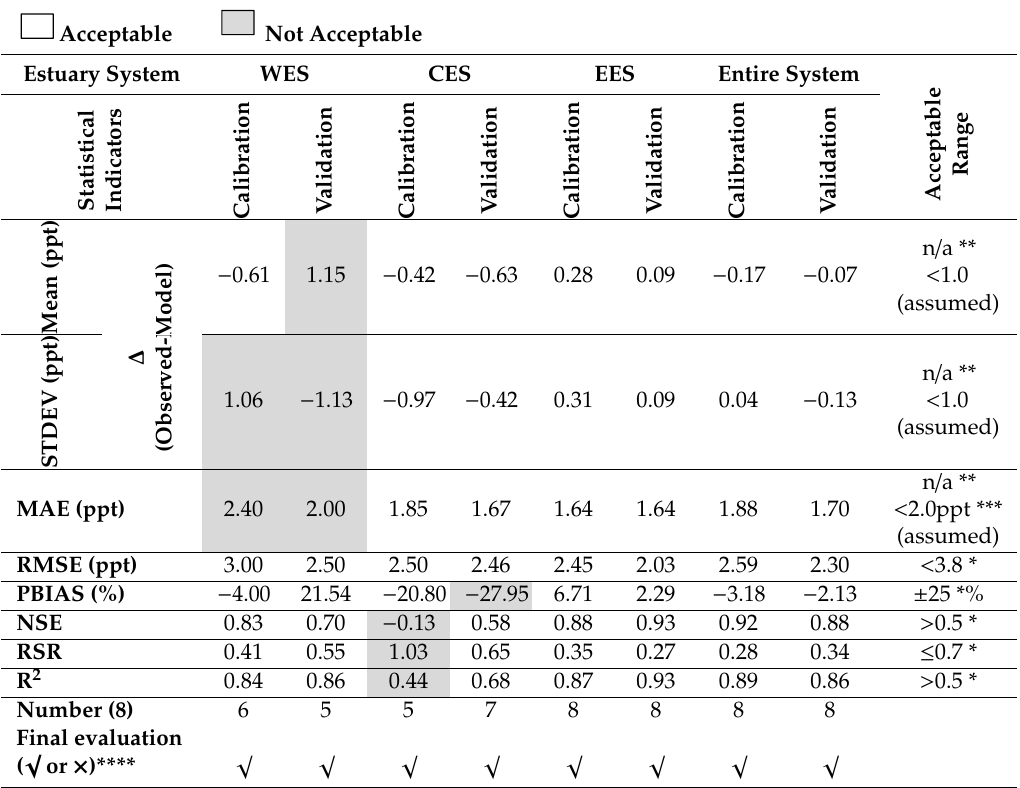
Table 2. Statistical indicators showing the model performance during calibration and validation.